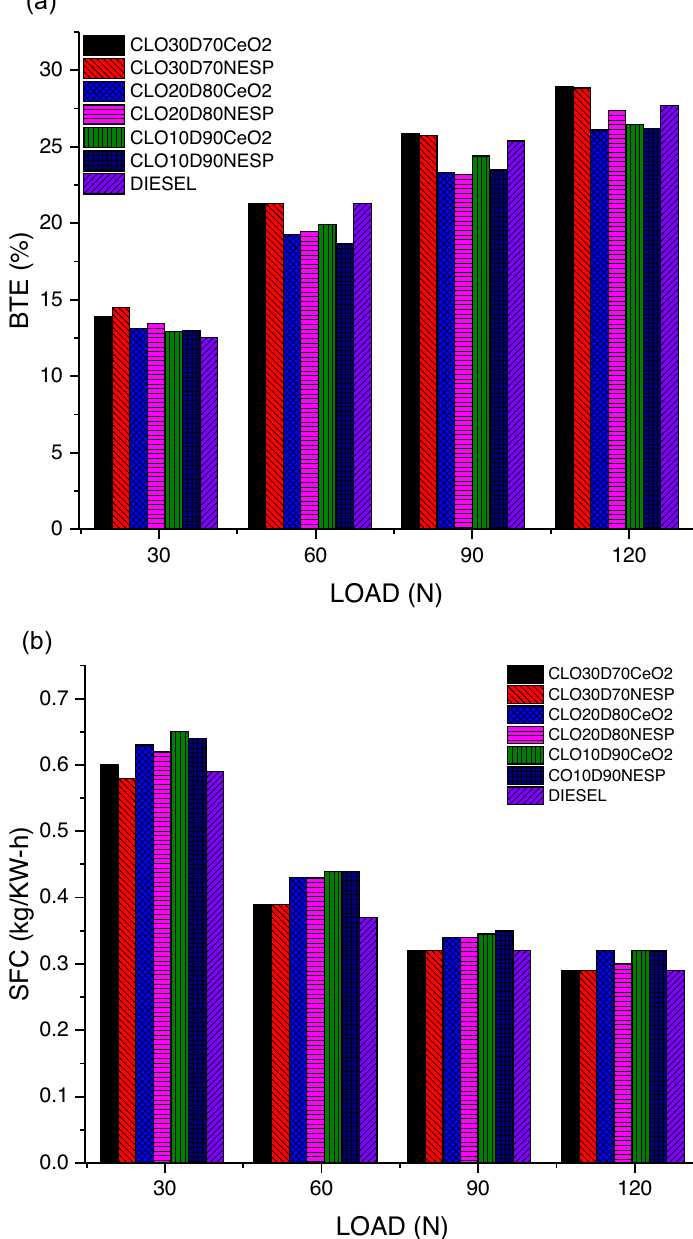
Fig. 3. (a) Break thermal ef fi ciency versus Load plot. (b) Speci fi c fuel consumption versus Load plot. (c) EGT versus Load plot. (d) Carbon monoxide emission versus Load plot. (e) Carbon dioxide emission versus Load plot. (f) Hydrocarbon emission versus Load plot. (g) NO X emission versus Load